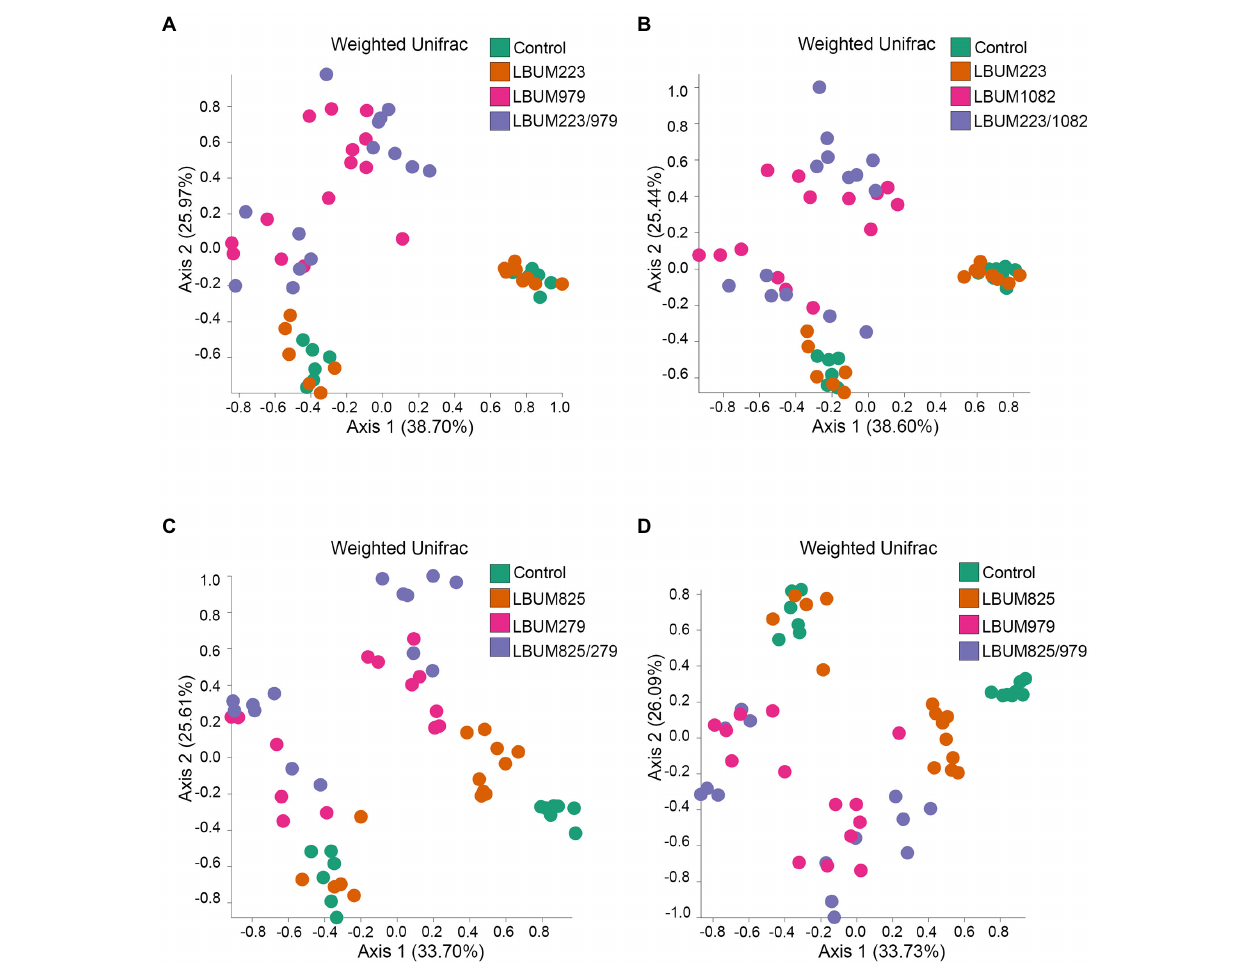
FIGURE 3 | Weighted UniFrac beta-diversity metric between treatment conditions in Promix rhizosphere. PCoA plot representative of beta-diversity between treatment groups; (A) LBUM223 and LBUM979, (B) LBUM223 and LBUM1082, (C) LBUM825 and LBUM279 (D) LBUM825 and LBUM979, alone or in combination (the control refers to plants inoculated with water). Pseudomonas spp. treatments are represented by orange circles, Bacillus spp. by pink circles, combinatorial treatments by purple circles and the controls in green. Each point represents a sample and axis 1 and axis 2 represent the percentage of variance explained by each coordinate. Statistical analysis is found in the text (ANOSIM and